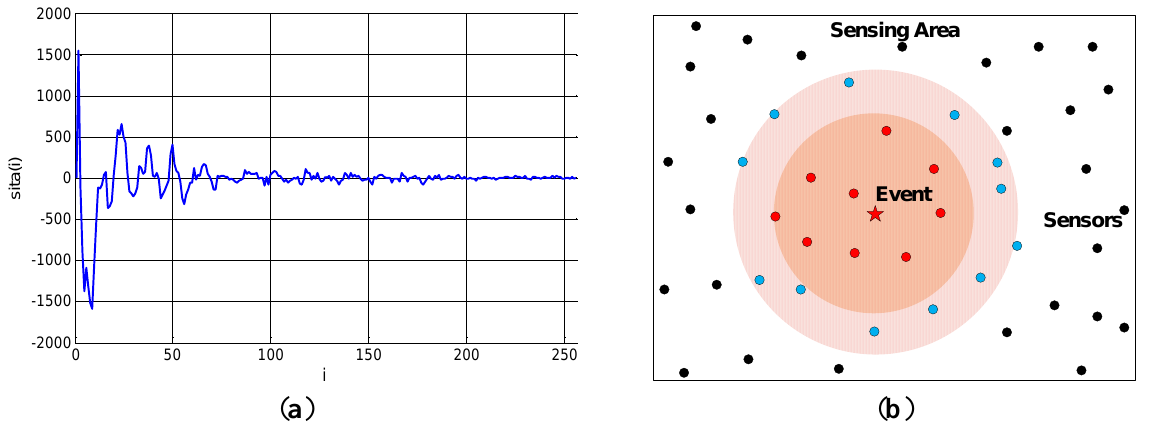
Figure 1. Examples of non-uniform compressible signals. ( a ) The DCT coefficients of the first 16 × 16 block in the first frame of “coastguard.qcif”. ( b ) The networked data scenario in wireless sensor